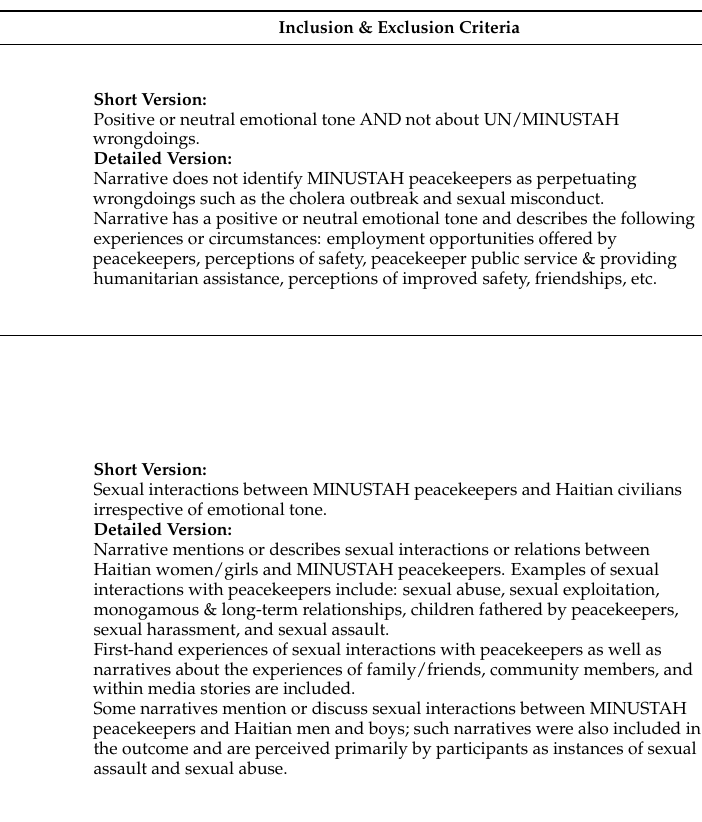
Table A3. Criteria used to classify narratives according to